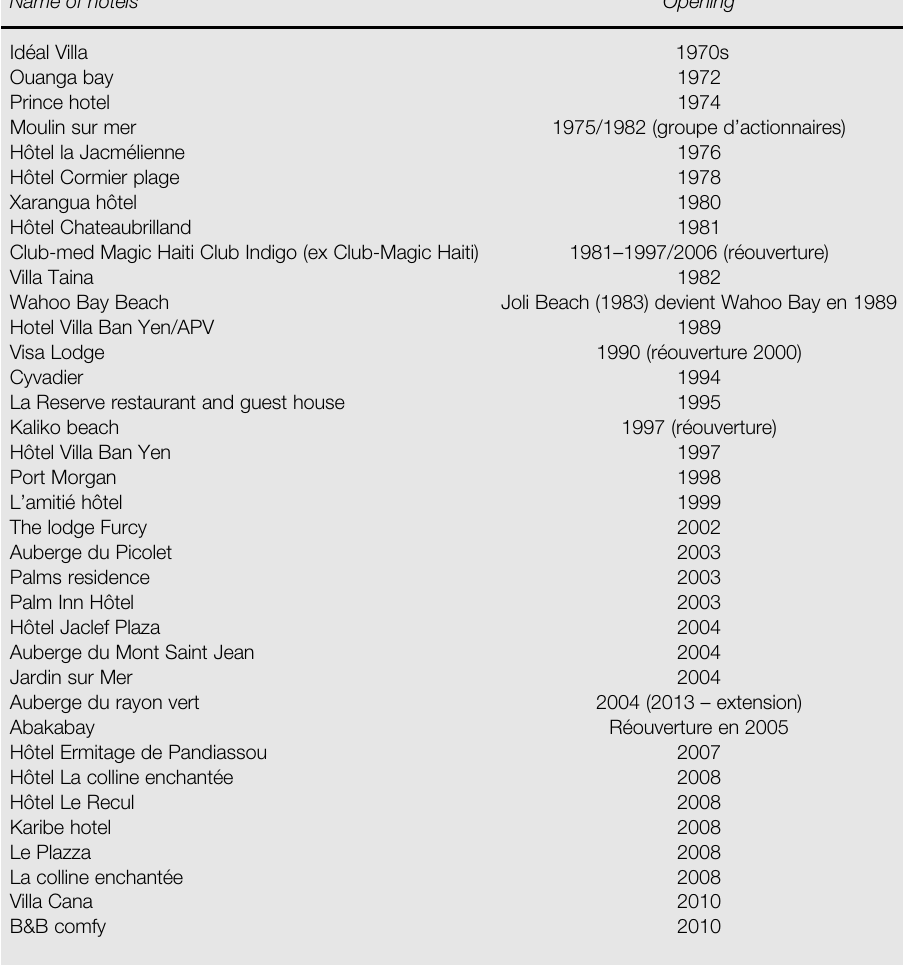
Table II Hotels built in Haiti 1960 –